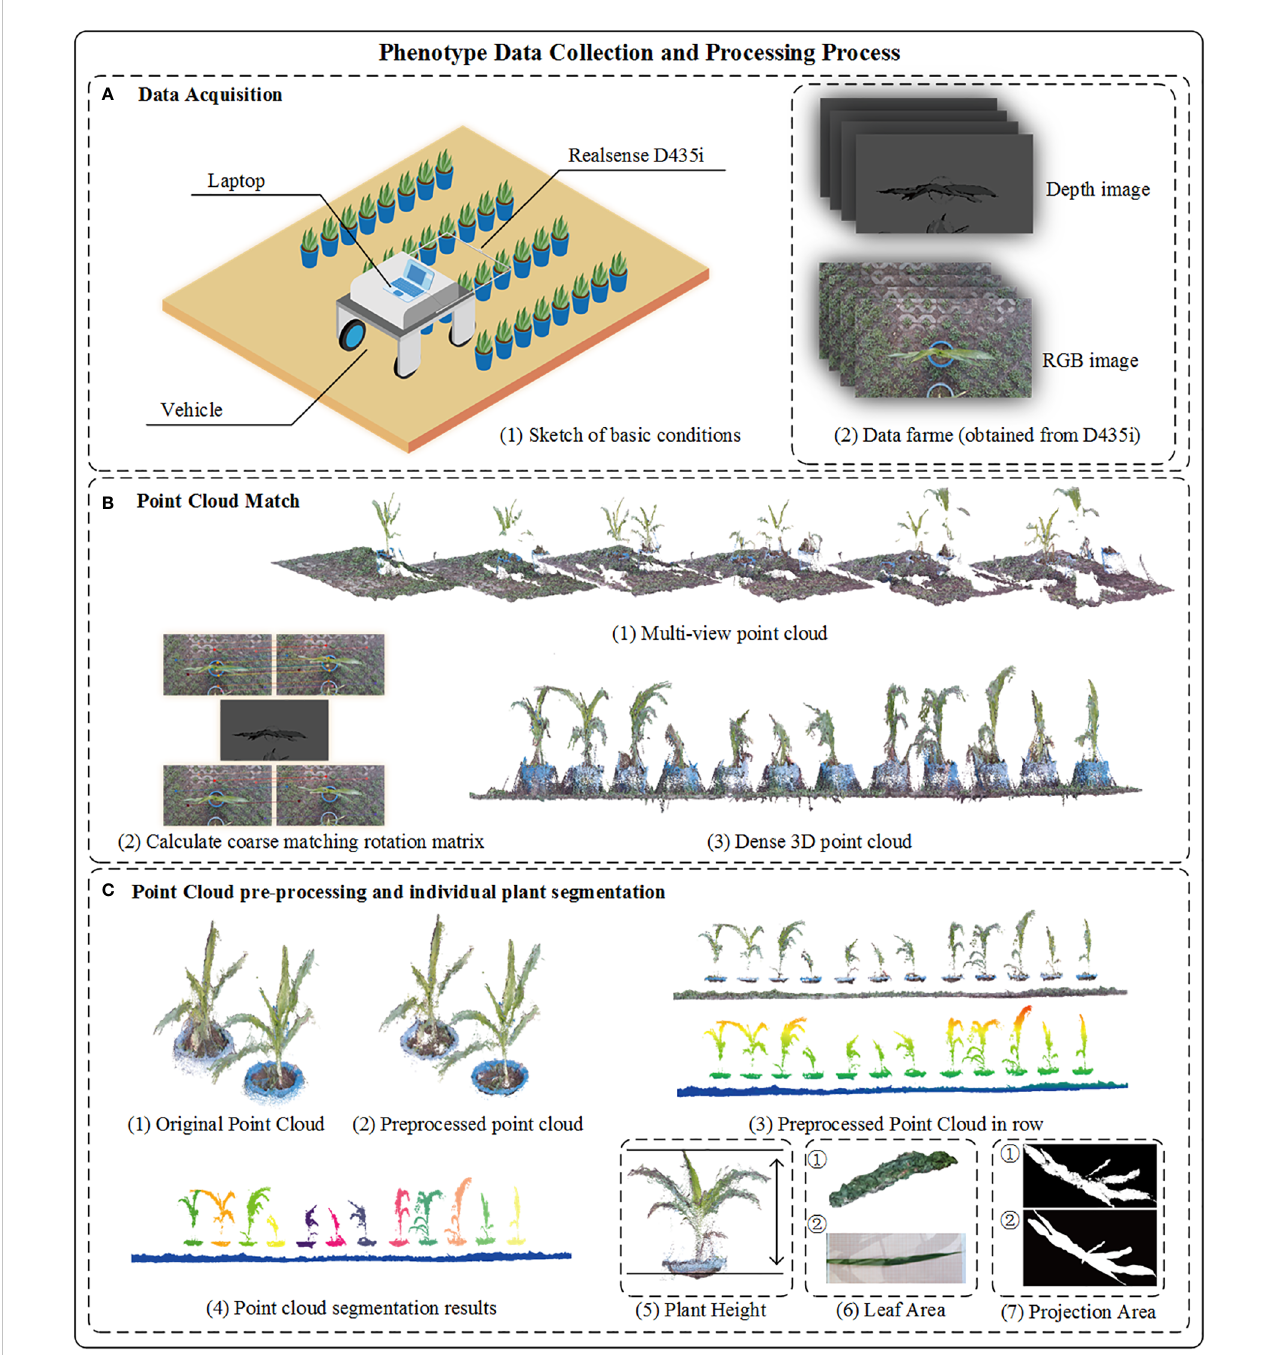
FIGURE 1 Overall process of crop 3D reconstruction and phenotyping. (A-1) The sketch of data acquisition. (A-2) Images capture from Realsense D435i, the original of depth image was saved as unit16 format, we have enhanced the depth image to facilitate readers ’ understanding in the fi gure. (B-1) Multi-view point cloud reconstruction from sequentially depth and RGB image. (B-2) The coarse rotation matrix calculate from adjacent image. (B-3) Result of fused point cloud captured in row. (C-1) Part of original point cloud in row. (C-2) Point cloud with preprocessed method. (C-3) Crop point cloud in row. (C-4) Results of individual plant by cluster method. (C-5) The plant height is from the point cloud plane to the top point. (C-6) ① The surface reconstruction result. ② Image of crop leaf. (C-7) Binary image of crop projection area ① view of maize point cloud ② view of maize top